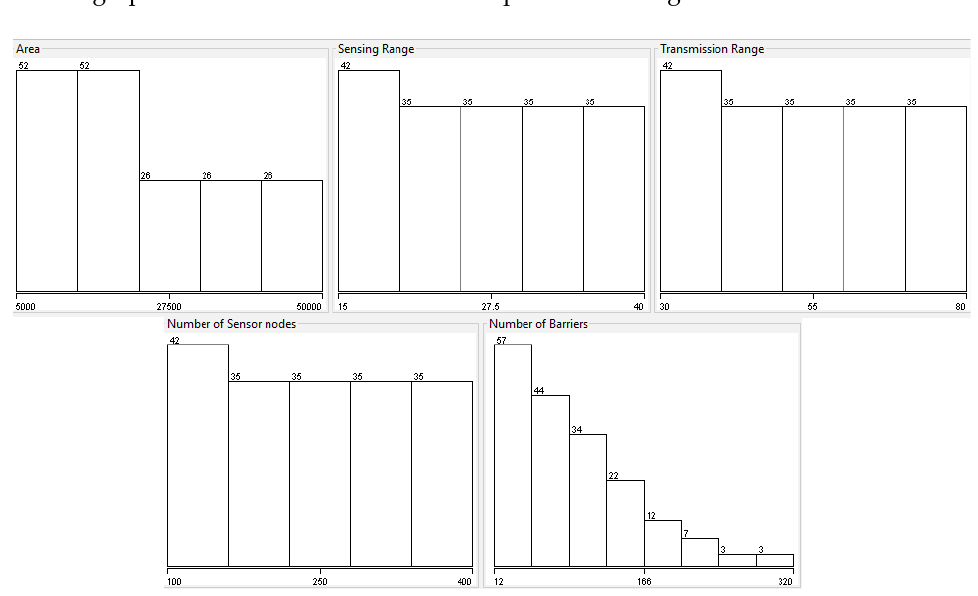
Figure 4. Graphical evaluation of the main features of the evaluated